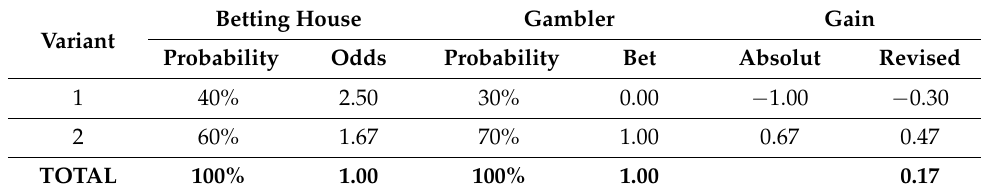
Table 3. The gain of the gambler appreciates the chances more accurately than the broker. Variant